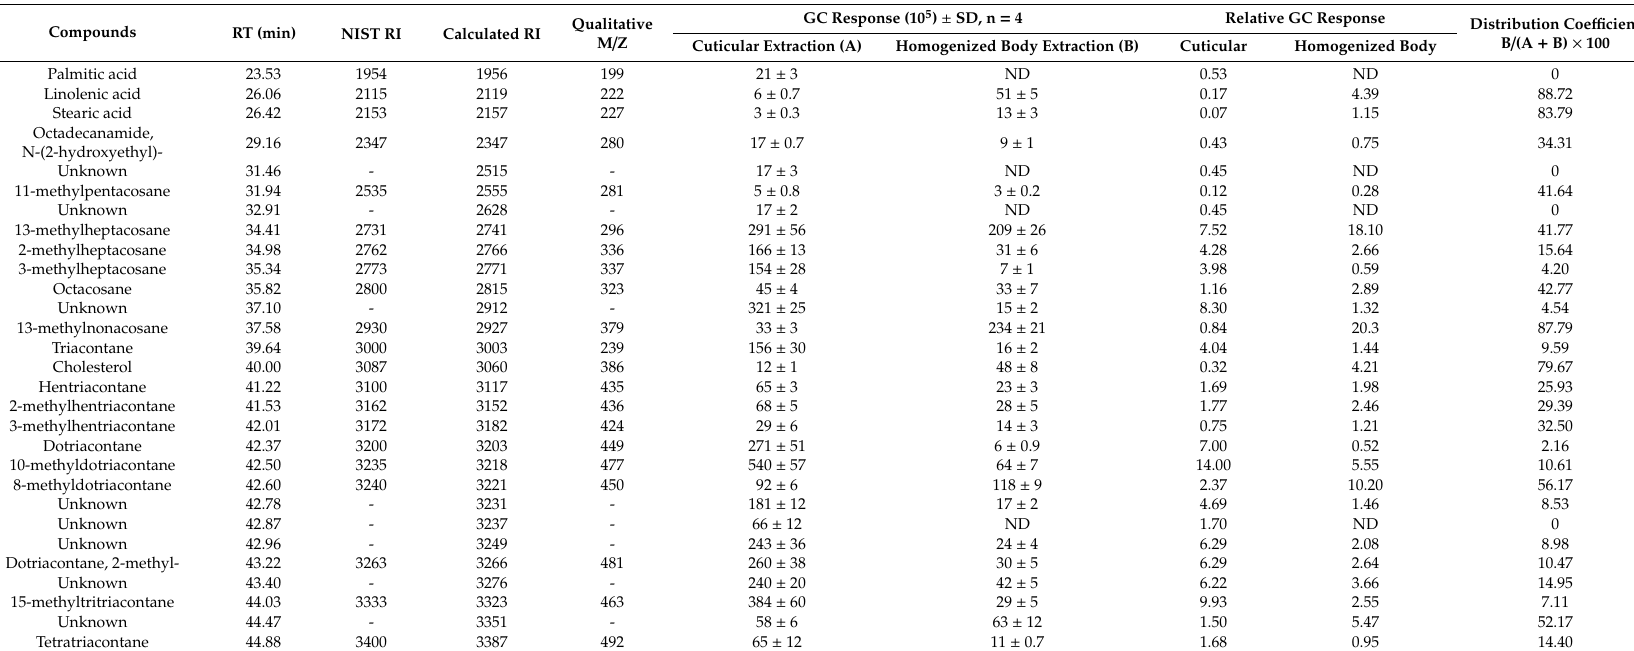
Table 4. Extracted and identified compounds from cuticle layer and homogenized body of R. dominica in